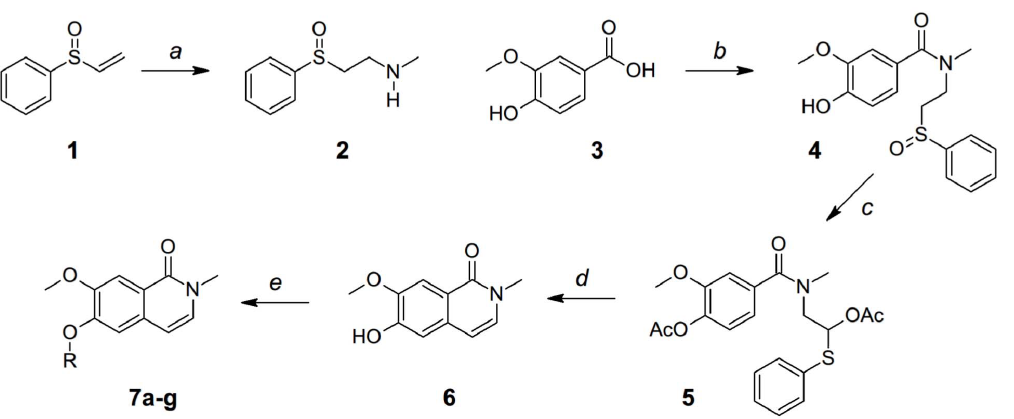
Figure 1. Synthesis of isoquinolinones 7a–g. a) MeNH 2 , THF, r.t., , 75%; b) DIC, 2 , CH 2 Cl 2 , r.t., 84–91%; c) Ac 2 O, reflux, , 100%; d) TsOH, toluene, heat, 71% for two steps; e) RX, K 2 CO 3 , DMF, r.t., , 95%.